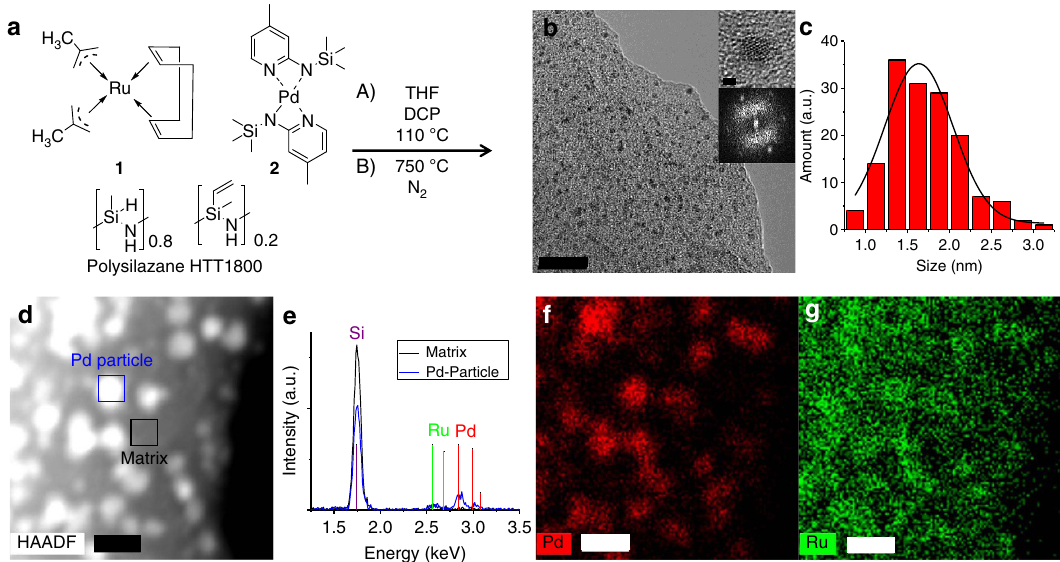
Figure 1 | Synthesis and characterization of the nanocomposite catalyst Pd 2 Ru@SiCN. ( a ) A solution of complex 1 and complex 2 in tetrahydrofuran (THF) was mixed with the polysilazane HTT1800 and crosslinked at 110 (cid:2) C for 24 h using dicumylperoxide (DCP) as a radical initiator. The solvent was removed and the resulting black–brown metallopolymer was pyrolysed under N 2 atmosphere at 750 (cid:2) C. ( b ) High-resolution TEM picture of the catalyst (scale bar, 20nm) with magnification of one Pd nanoparticle and fast Fourier transform (FFT, scale bar, 1nm). ( c ) Pd particle size distribution. ( d ) High- angle annular dark-field (HAADF) picture (scale bar, 5nm). ( e ) Energy dispersive X-ray spectroscopy (EDX) analysis of the matrix and Pd particle. ( f ) EDX mapping of Pd (scale bar, 5nm). ( g ) EDX mapping of Ru (scale bar, 5nm). a.u., arbitrary